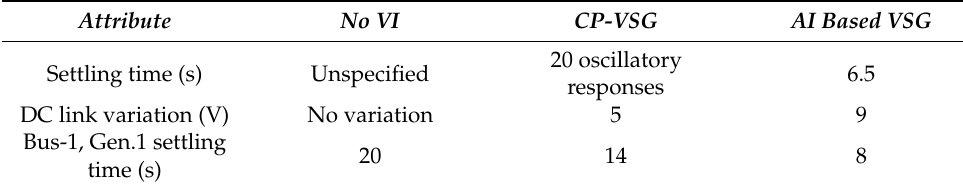
Table 5. Time–domain specifications with off-shore performance assessment.